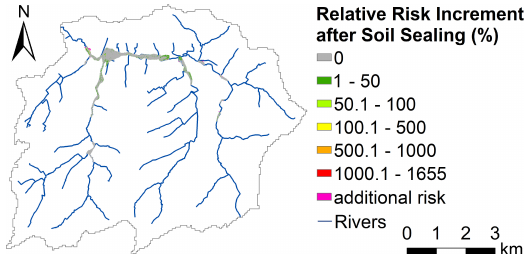
Figure 11. Relative flood risk increment (%) in the flooded areas in the Maarkebeek catchment after sealing the 750 highest-ranked pixels in this land use change scenario. New areas being flooded after soil sealing are depicted as “additional